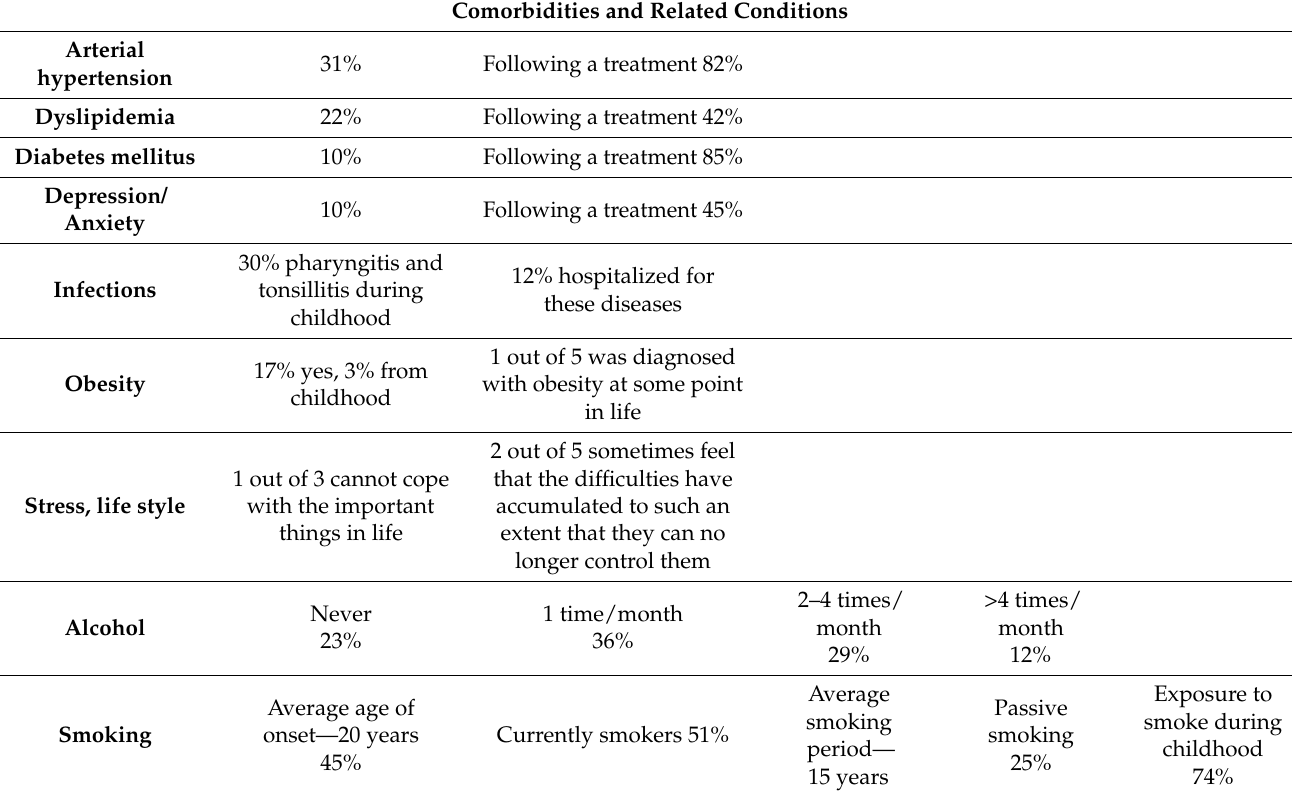
Table 4. Comorbidities and related conditions resulting from the national study (N = 1500 respondents). Comorbidities and Related